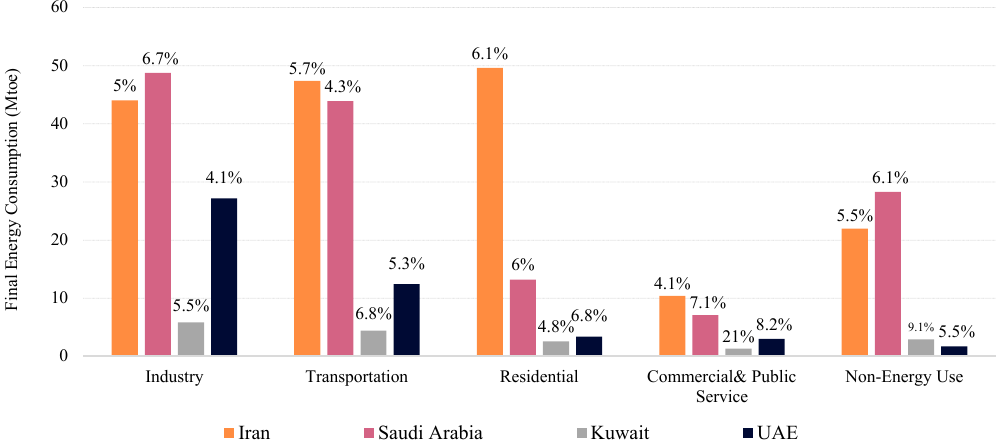
Figure 5. Final energy consumption by sector in 2014. Percentage refers to annual growth rate since 1990. Based on data from [22].